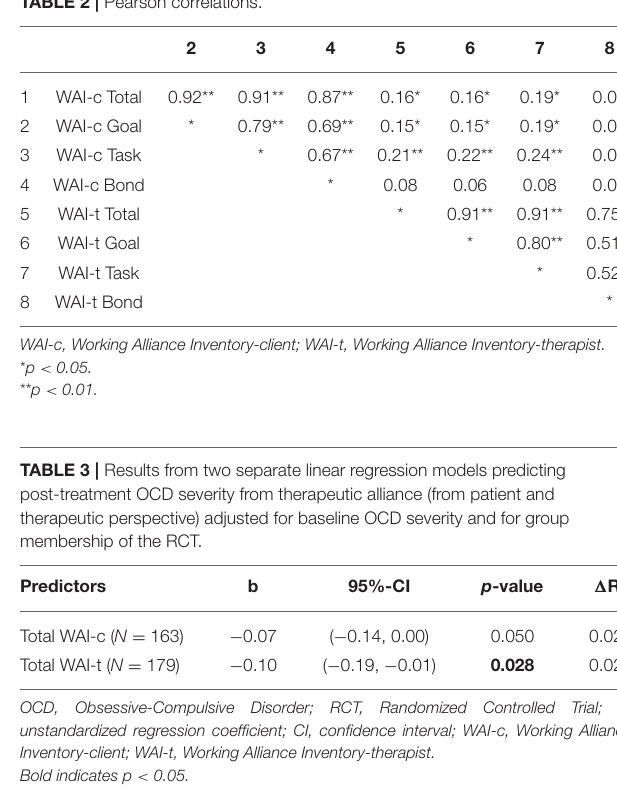
TABLE 2 | Pearson correlations.